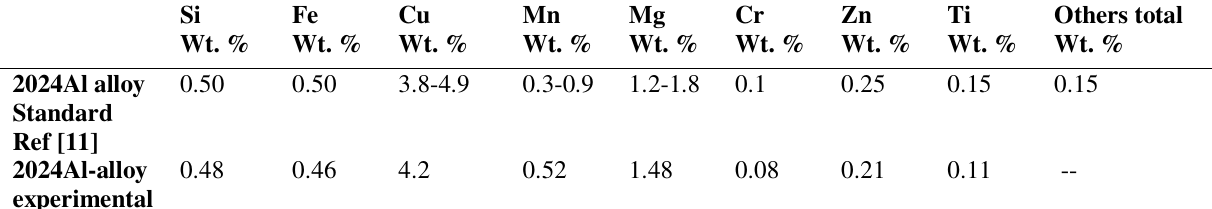
Chemical Composition wt. % of 2024/Al